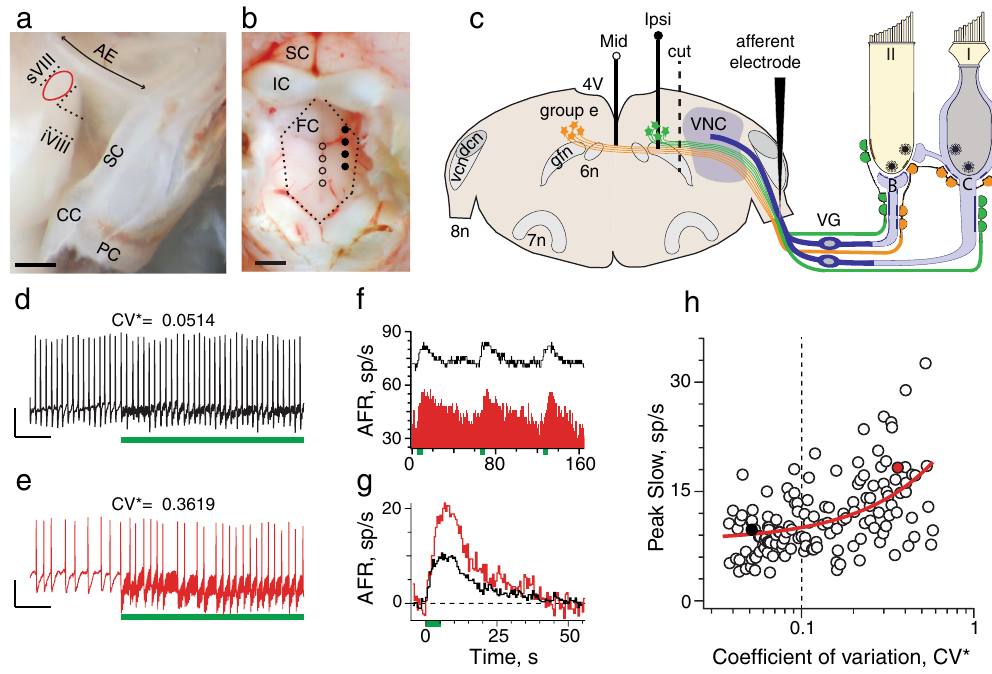
Figure 1. Electrical stimulation in the brainstem slowly excites vestibular afferents. ( a ) Right bony labyrinth w/dashed lines outlining positions of superior (sVIII) and inferior (iVIII) divisions of cranial nerve VIII (8n) dorsally obscured by the brainstem (i.e., cochlear nuclei). CC, common crus; SC, PC superior and posterior canal. Afferent recordings were confined to sVIII (red dashed oval), mediocaudal to the arcuate eminence (AE). ( b ) EVS electrode placement in floor of fourth ventricle: Circles—open, midline; filled, ipsilateral. FC, IC, SC: facial, inferior, and superior colliculus. ( c ) Coronal brainstem section showing EVS nuclei (i.e. group e) and projections to peripheral hair cells and afferents. In vestibular neuroepithelium, primary vestibular afferents (blue), innervating type I and/or type II hair cells, collect in 8n and project to the vestibular nuclear complex (VNC). In the brainstem, contralateral efferent neurons (orange) cross the midline to join ipsilateral efferents (green) with both exiting 8n. Efferent neurons pass through the vestibular ganglion (VG) without synapsing on cell bodies for primary vestibular afferents 8,86 . Upon reaching the neuroepithelium, EVS neurons produce many varicosities innervating type II hair cells and their bouton afferents (B), as well as calyx-bearing afferents (C) innervating type I hair cells. Key: 4V, 4th ventricle; 6n, abducens nucleus; 7n, facial nucleus; dcn, vcn, dorsal and ventral cochlear nuclei; gfn, genu of facial nerve. ( d,e ) Regularly (black; 2 mV, 100 ms) and irregularly-discharging (red; 0.5 mV, 100 ms) afferent showing onset of midline brainstem stimulation (333 shocks/s, green bar), respectively. ( f ) Corresponding continuous histograms showing changes in afferent firing rates (AFR) during three successive midline stimulation trials (333/s for 5 s delivered every 60 s, green boxes). ( g ) Corresponding average response histograms after background subtraction (n = 7 trials/unit). ( h ) Mean peak slow excitation, averaged from a 1-s block at t = 6–7 s, is plotted versus CV* for 144 units (n: 65 regular, 79 irregular). Vertical dashed line separates regular from irregular afferents. Filled color circles correspond to units shown in panel g . Red line; linear fit of the data. Scale bars: a = 1 mm; b = 0.5 mm. Binning in panels ( f) and ( g) is 500